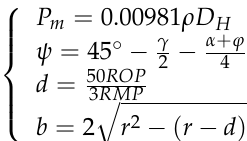
Figure 6. Comparison of numerical simulation ( F c) and cutting force calculation ( F c *). Numerical simulation studies were carried out on the five cutter types, comprising the circular, wedge, triangular, axe, and bevel cutter, according to the experimental scheme in Table 3. Taking igneous rock as the research stratum, the rock breaking perfor- mance of the cutters at the cutting depths ( d ) of 2, 2.5, 3, and 4 mm under the conditions of a rotational speed of 80 r/min, a cutter diameter of 16 mm, and a back inclination angle of 15°, were calculated. Table 3. Numerical simulation experiment scheme of cutter breaking rock. Rock